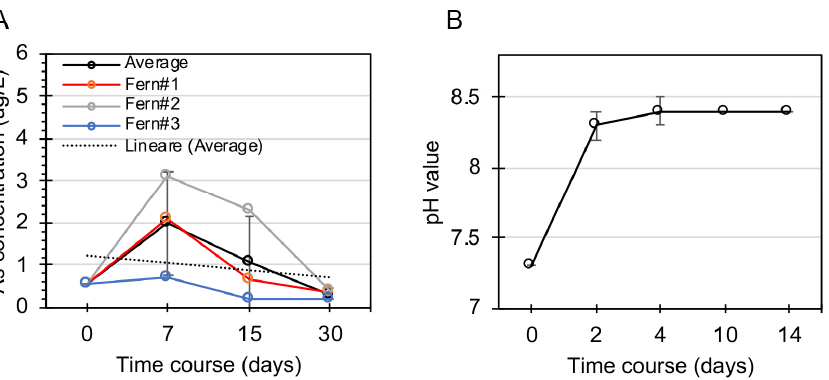
Figure 5. Arsenic excretion and pH changes during N cycle after phytofiltration cycle 1. (A) Evaluation of As excretion by ferns. As concentration in water was measured at different timepoints, from 1 to 60 days. Fern #1 red line; Fern #2 grey line; Fern #3 blue line; average black line; ( B ) linear average dashed line pH was monitored by subsequent water samplings. Ferns #1–3, grown in individual buckets, were used and the average of samplings for each timepoint is reported. Error bars are means ± SD.